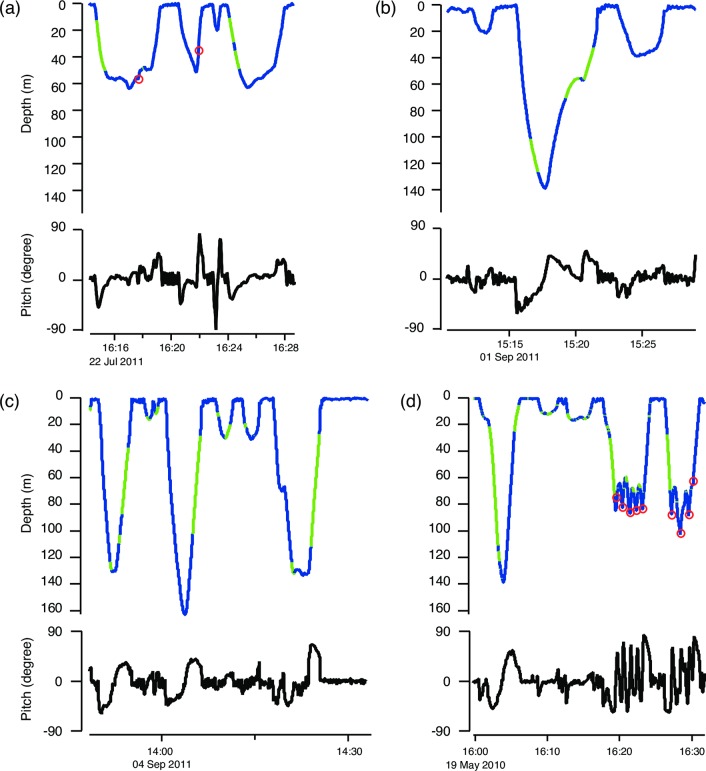
Example data records for dive profile and pitch.Dive profile with gliding and stroking periods are indicated in green and blue, respectively. Red circles indicate feeding events. Examples are taken from an adult male during (a) early feeding season (Mn11_H607_1; tissue density = 1037.0 kg m-1) and (b) late feeding season (Mn11_H607_2; 1031.2 kg m-1), (c) a pregnant female (Mn11_H002; 1026.5 kg m-1) and (d) a calf (Mn10_139a; 1040.8 kg m-1).